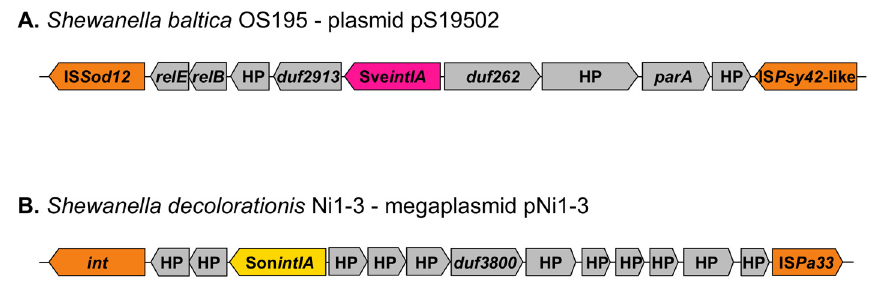
Figure 5. Genetic context of integrase genes found in plasmids from Shewanella spp. ( A ) Integrase gene Sve intIA encoded in plasmid pS19502 from S. baltica OS195 (CP000893.1). ( B ) Integrase gene Son intIA encoded in megaplasmid pNi1-3 from S. decolorationis Ni1-3